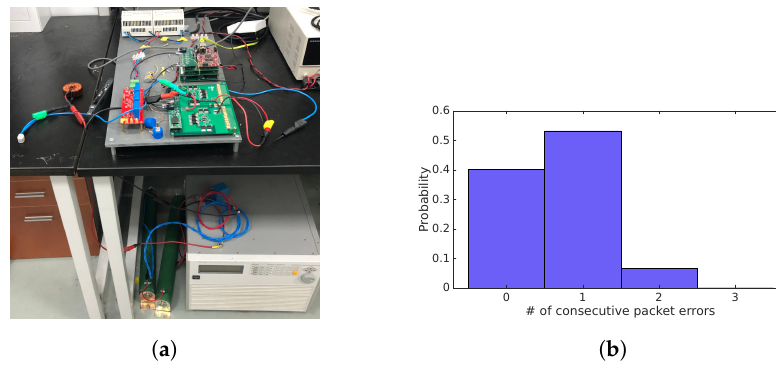
Figure 12. ( a ) Experimental setup and ( b ) packet error distribution used in the